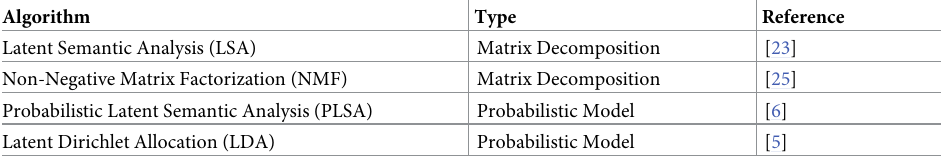
Table 1. Topic modeling algorithms included in the experiments of this